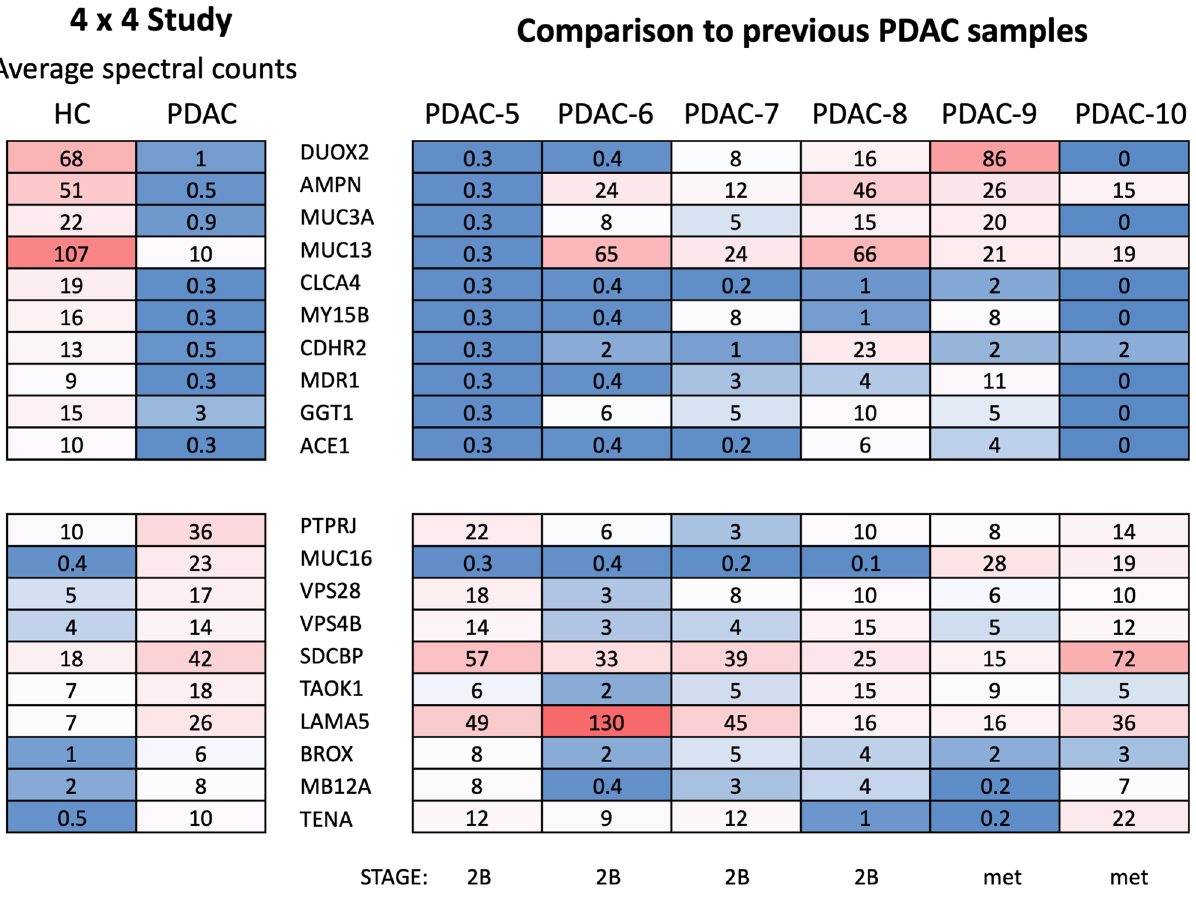
Figure 6. Upregulated proteins analyzed in additional PDAC organoid EVs. Comparison of average spectral counts of top proteins identified in the 4 × 4 study (see Fig. 4) to normalized spectral counts for each corresponding protein in six additional PDAC organoid EV samples. PDAC stage is shown for each PDAC organoid ( met metastatic tumor